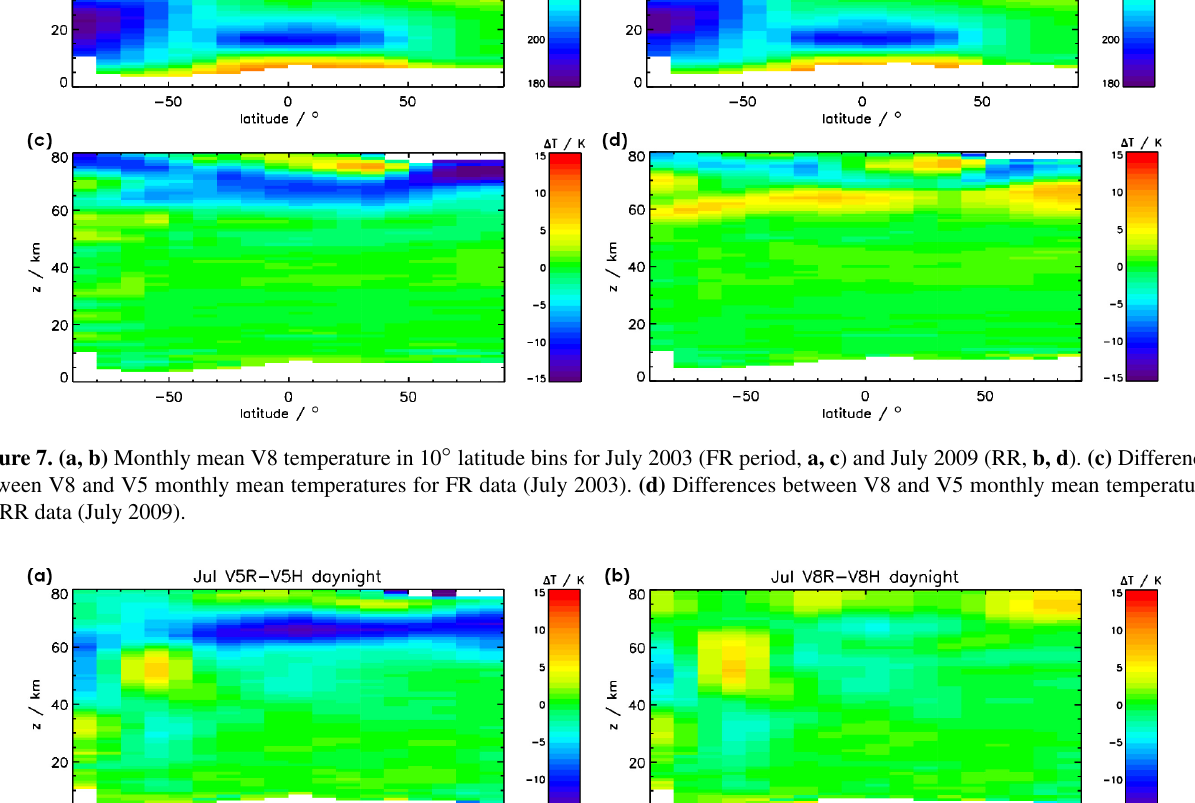
vertically smoothed temperature profile for retrieval and a priori data. Smoothing is done with a boxcar of 10 km